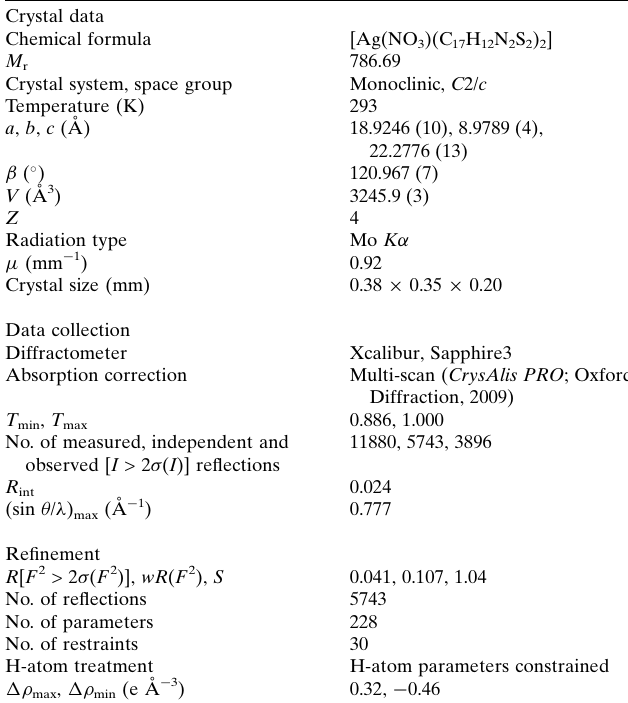
Table 1 Selected geometric parameters (A˚ , (cid:2)